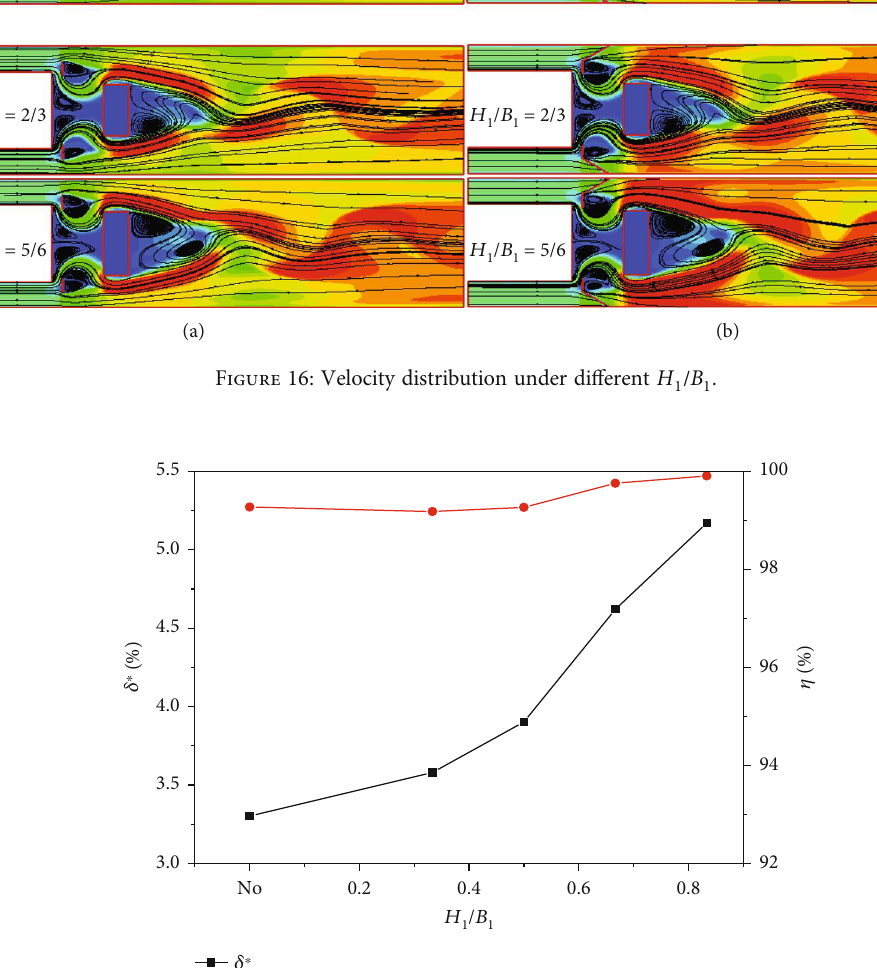
Figure 17: Total pressure loss and combustion e ffi ciency under di ff erent H